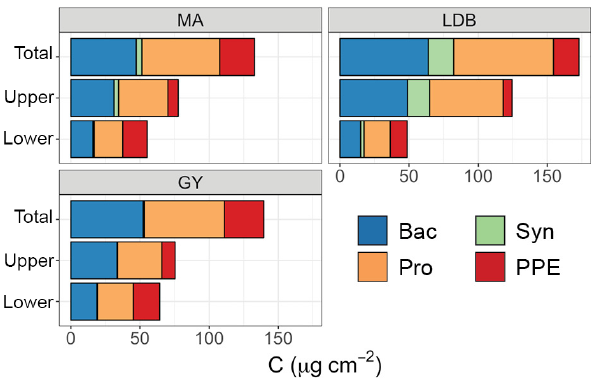
Figure 4. Contribution of different plankton groups (heterotrophic bacteria (Bac, blue), Synechococcus (Syn, green), Prochlorococ- cus (Pro, orange), and picophytoeukaryotes (PPE, red)) to depth- integrated biomass, averaged by biogeochemical region (MA, LDB, GY). The y axis corresponds to a layer of the euphotic zone, with “total” representing integrations from surface to PAR 0 . 1 , “upper” representing integrations from surface to PAR 2 . 7 , and “lower” re- ferring to depths between PAR 2 . 7 and PAR 0 . 1